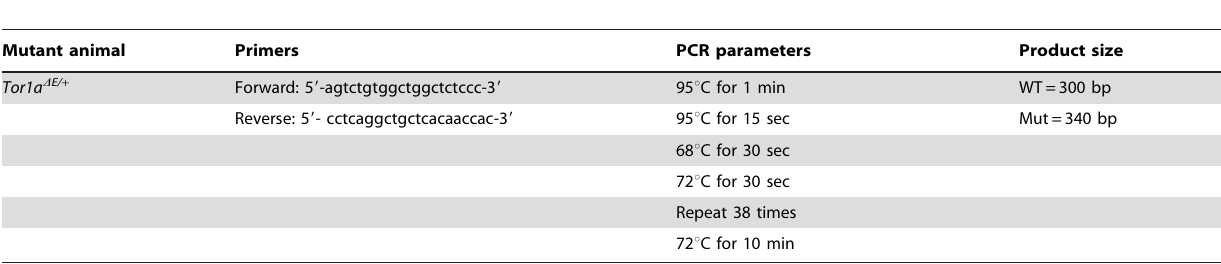
Table 1. Genotyping parameters for Tor1a knock-in mice.